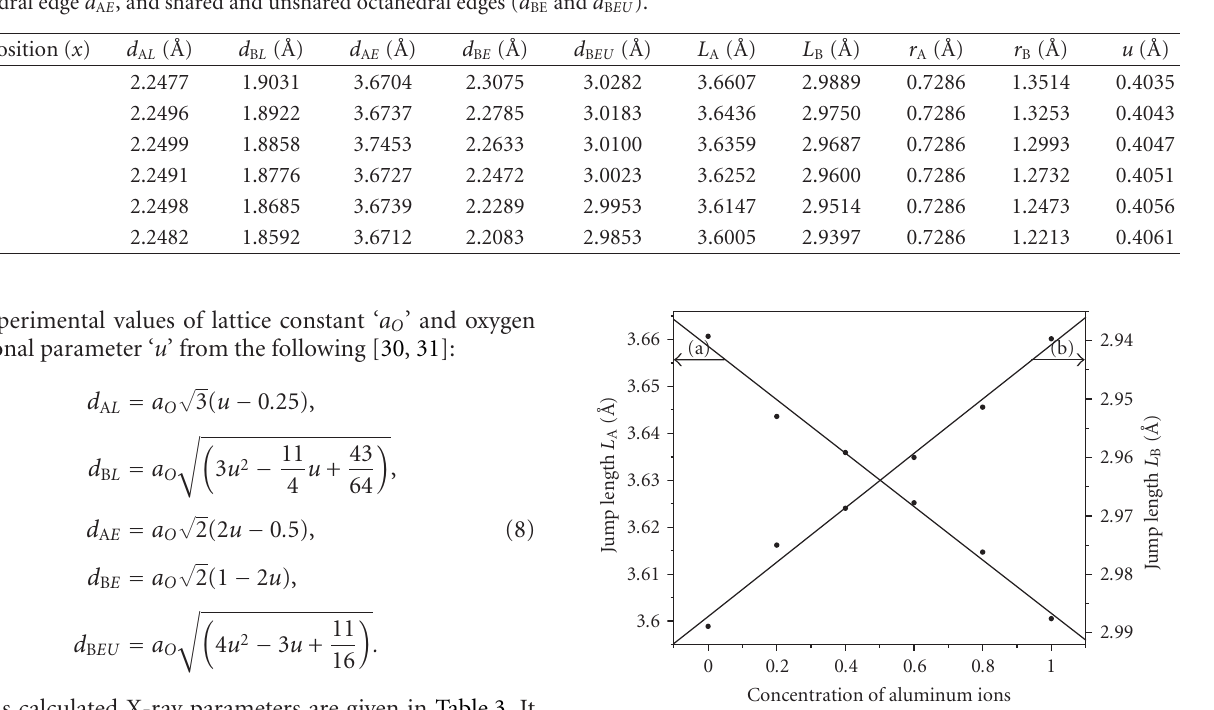
Figure 3: Variation of jump length ‘ L ’ with aluminum ions concen- tration.